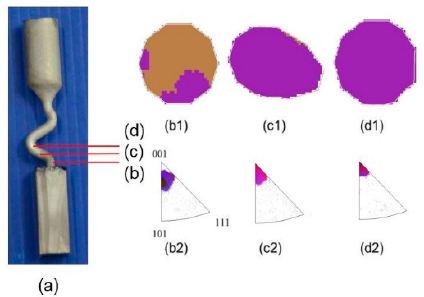
Figure 3. Experimental structure of a portion of the new selector with a thickness of 3 mm and a take-off angle of 40 ◦ ( a ); electron backscattering diffraction (EBSD) IPF-X (color code chosen along the growing direction) maps of the grain structure evolution ( b1 – d1 ) and the EBSD inverse pole figures in growth direction with various heights ( b2 – d2 ).